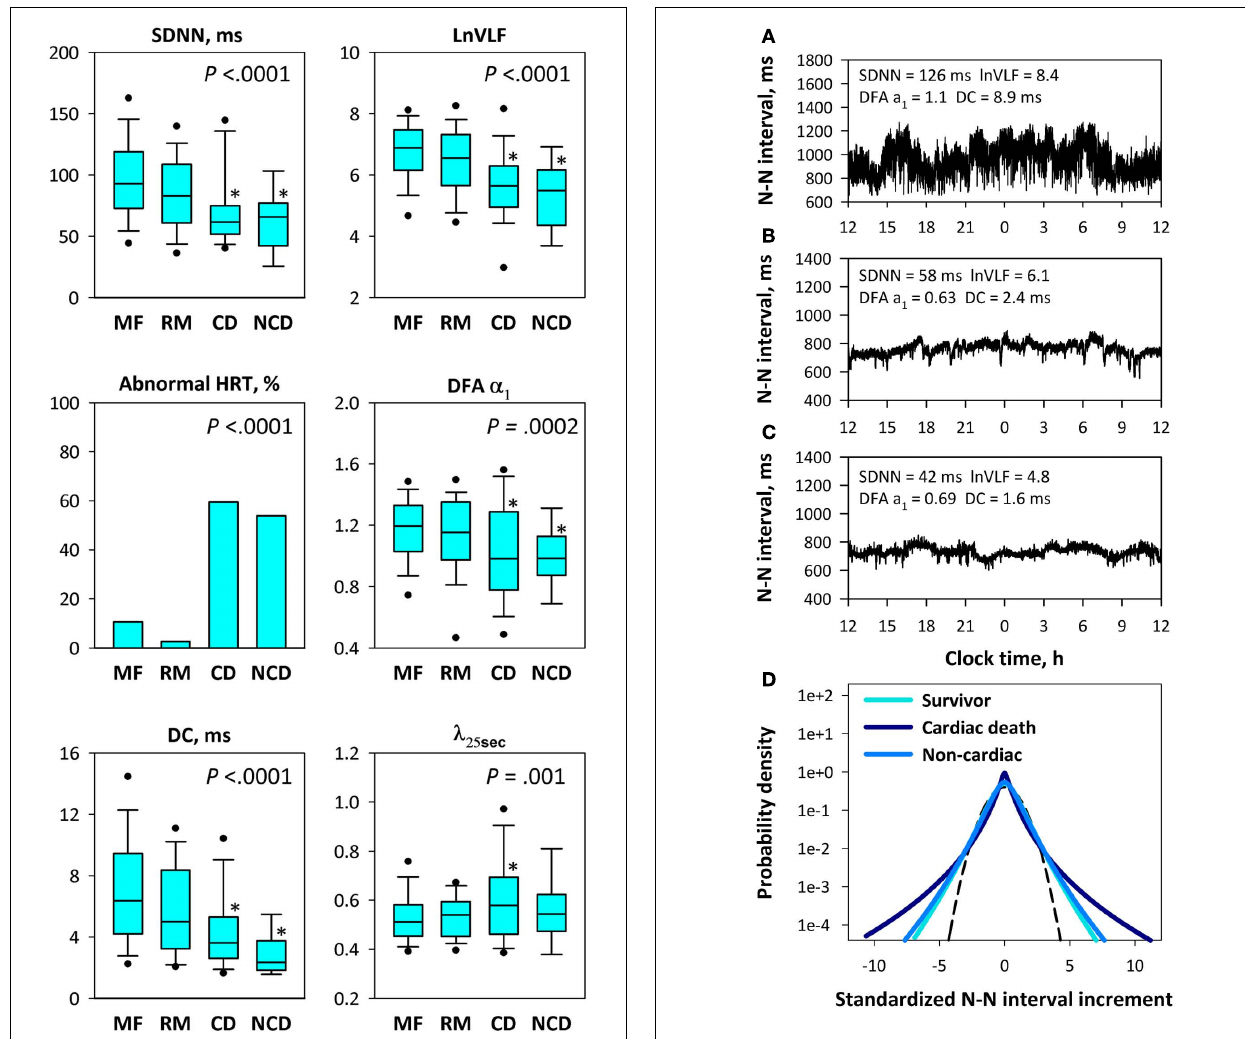
FIGURE 2 | Heart rate variability indices, HRT, and non-Gaussianity index ( λ 25s ) in post-AMI patients grouped by the endpoint of follow-up: MF, recurrentAMI-free survival; RM, recurrent non-fatalAMI; CD, cardiac death; and NCD, non-cardiac death. For box plots, upper and lower boundaries of the box indicate the 75th and 25th percentiles and a line within the box marks the median.Whiskers above and below the box indicate the 90th and 10th percentiles and dots above and below the whiskers indicate 95th and 5th percentiles. P values show significance of ANOVA except for abnormal HRT, for which bar graphs show percentage of patients who showed abnormal HRT and P value indicates the significance of chi-square test. *Significantly different from the value for recurrent AMI-free survivors (Tukey’s Studentized range test).